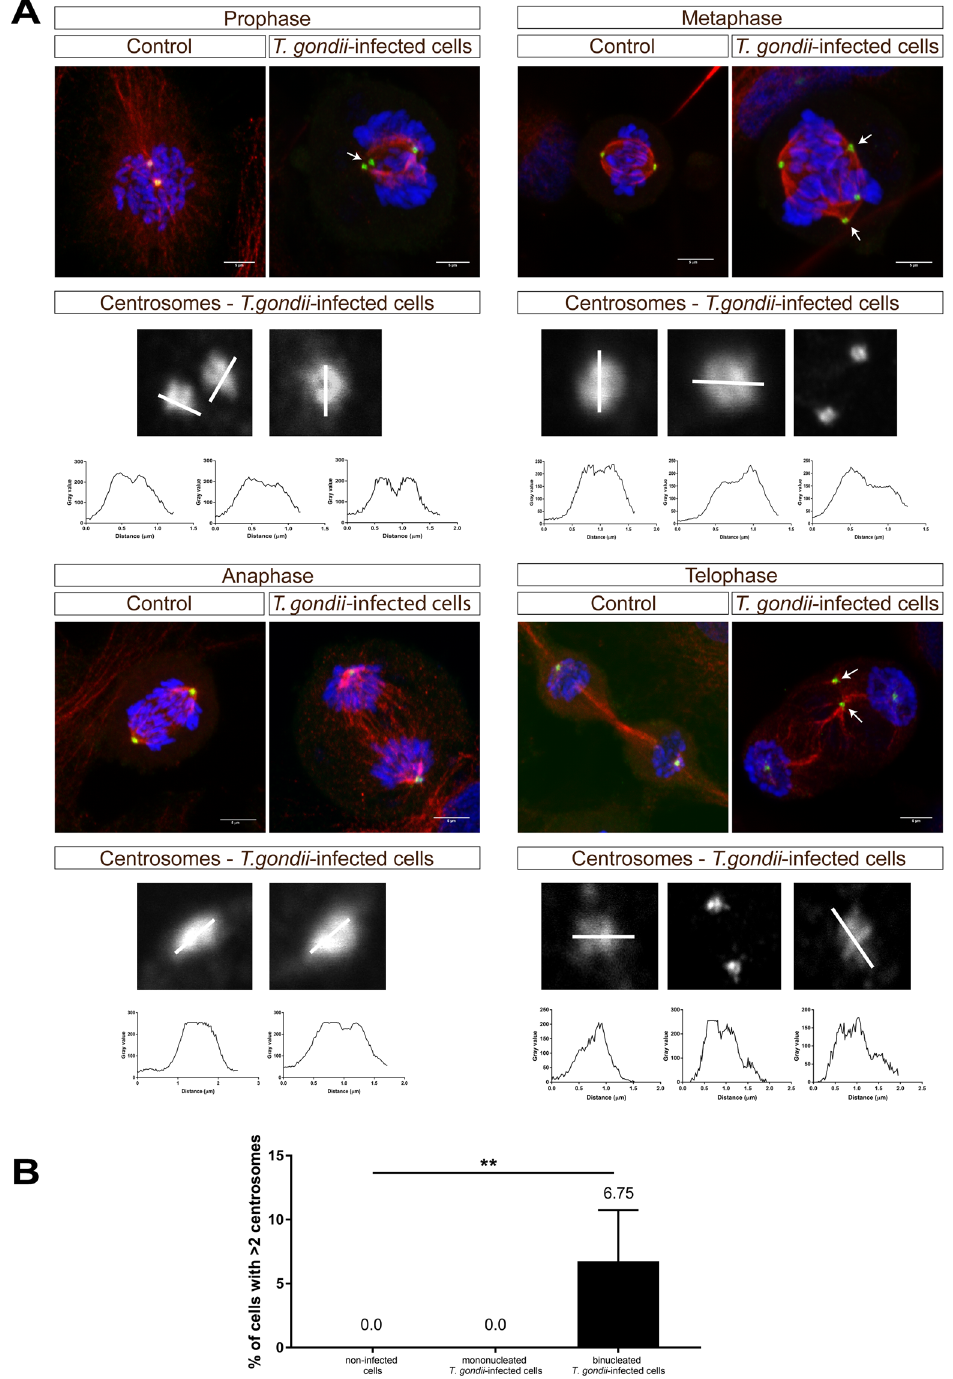
Figure 5. Mitotic spindle and centromer formation in T. gondii -infected BUVEC. ( A ) T. gondii -infected BUVEC and control cells were stained for chromosomes by DAPI (blue), for mitotic spindles by α -Tubulin (red) and for centromeres by γ -Tubulin (green) and analyzed via confocal microscopy. Additionally, the intensity of centromer-related signals was assessed and plotted as a graph showing intensity value vs distance (in µ m). Scale bar represents 5 µ m. ( B ) The number of centrosomes in mitotic cells, in T.gondii-infected BUVEC and control cells, were counted, and graph as a percentage of the total mitotic cells in the monolayer. Bars represent the median ± SEM. Bars represent the median ± SEM. Nonparametric one-way ANOVA (Kruskal- Wallis post-test), ** p ≤